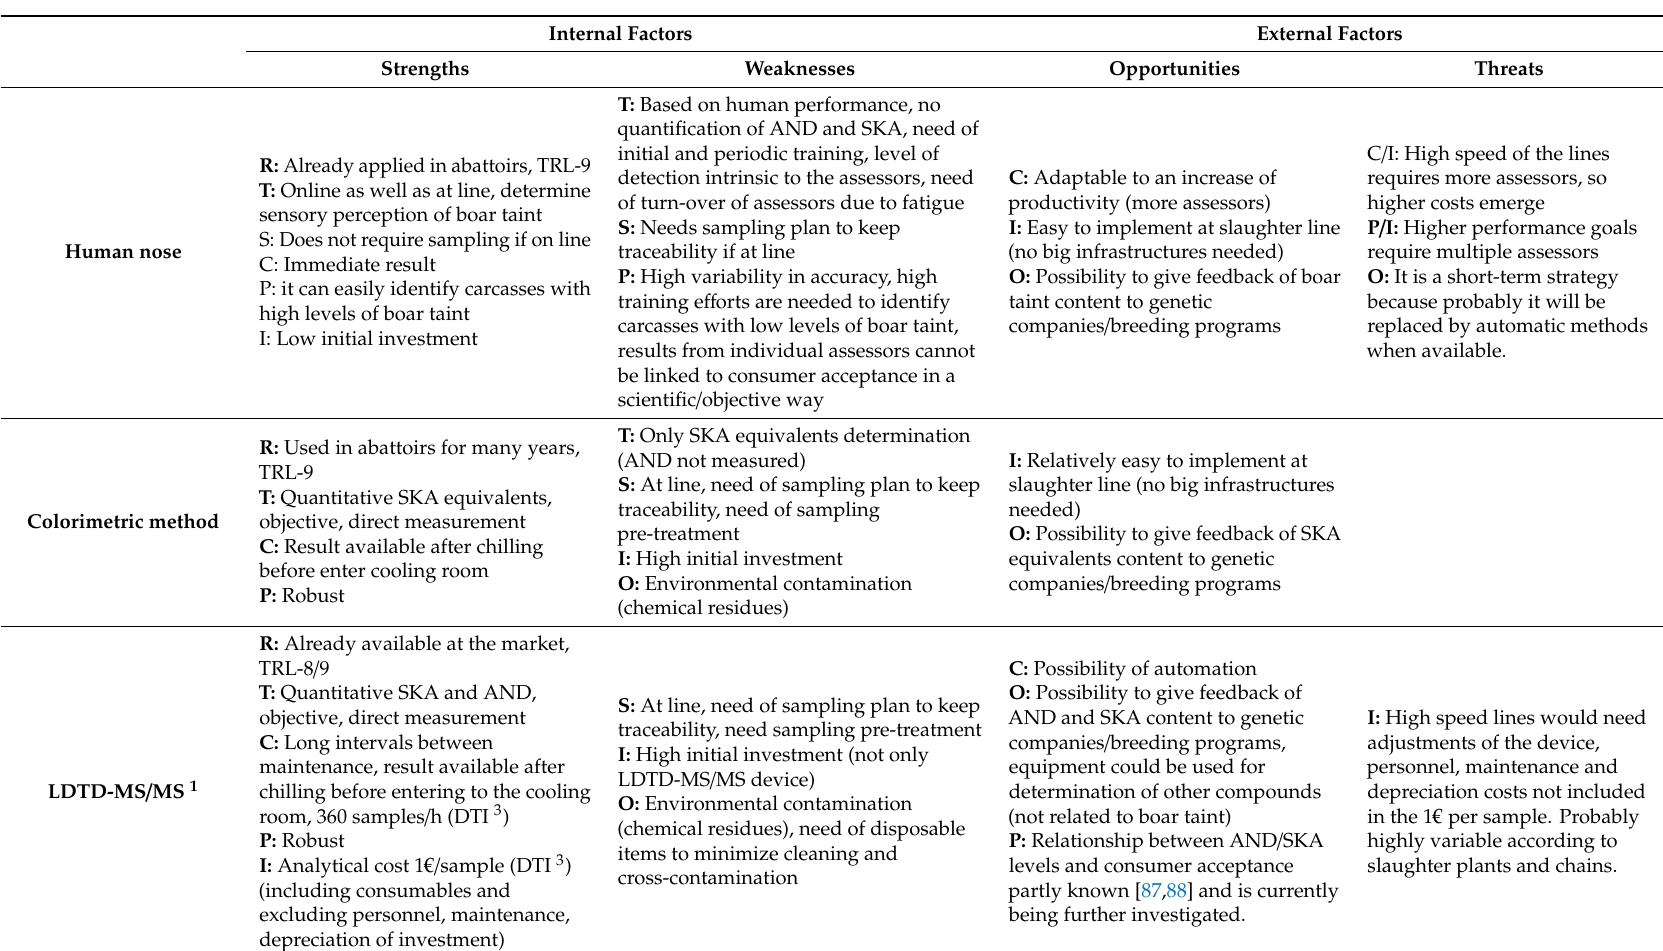
Table 1. Strength, Weaknesses, Opportunities and Threats (SWOT) analysis of the six compared methods according to readiness ( R ), type of measurement ( T ), traceability and sampling pre-treatment ( S ), Speed and capacity ( C ), performance ( P ), investment costs ( I ), and other aspects ( O